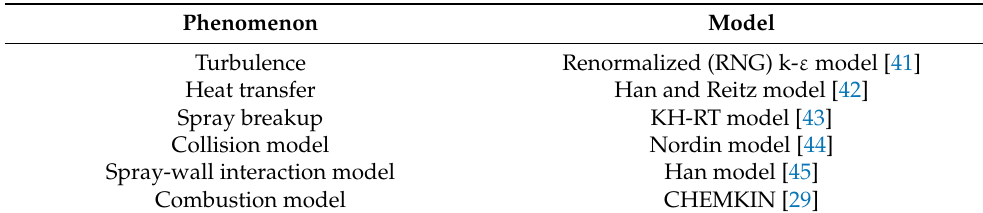
Table 3. Computational sub-models used in the engine simulations.